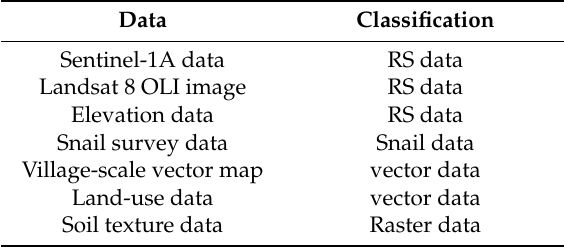
Table 1. Relevant input